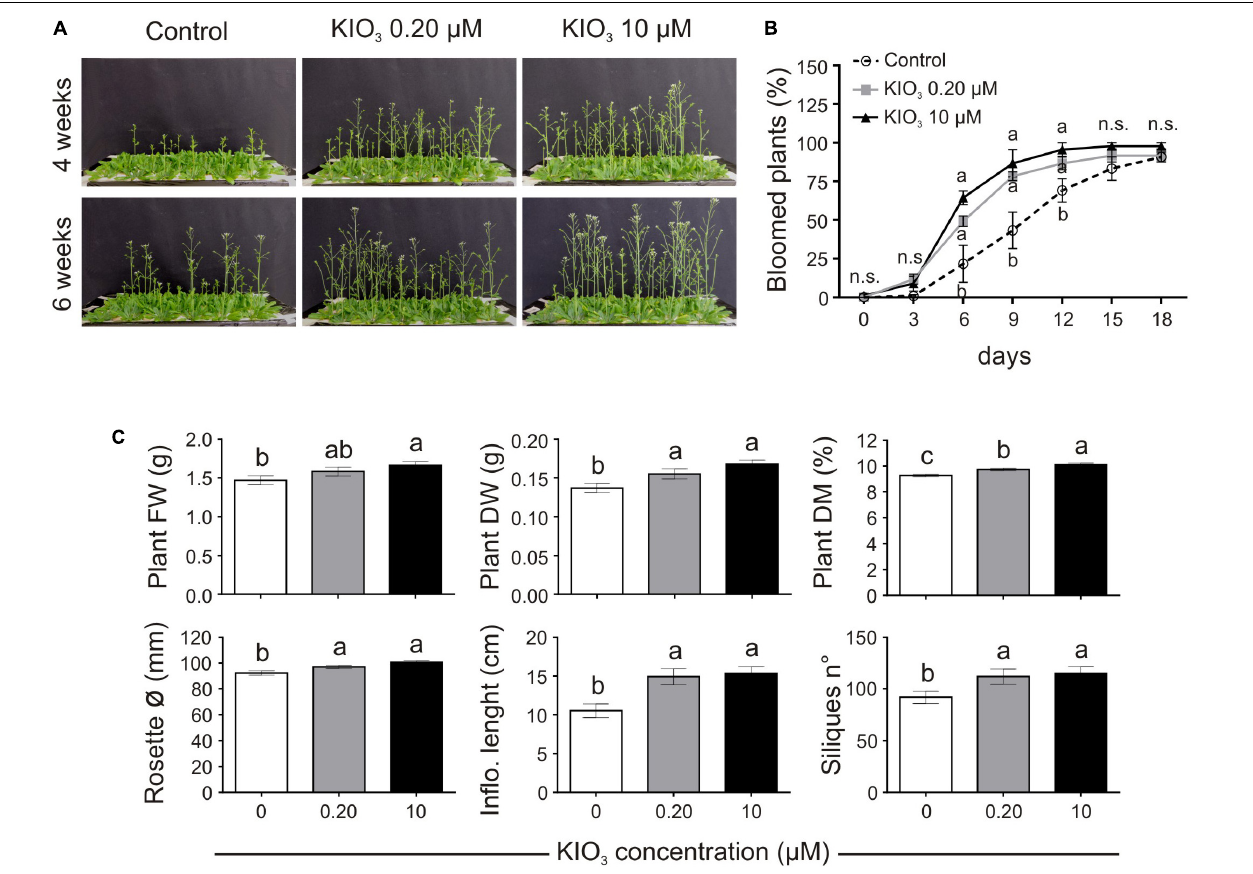
FIGURE 1 | Impact of iodine on plant growth and development (exp. 1-phenotype). (A) Lateral view of plants after 4 or 6 weeks from the onset of KIO 3 treatment. (B) Flowering time curve; the percentage of bloomed plants/tray was calculated every 3 days after the opening of the first flower (day 0). (C) Morphological data on plant FW, DW, dry matter content, rosette diameter, inflorescence length and number of produced siliques/plant, determined 1 month after the onset of KIO 3 treatments. Values indicated by different letters significantly differ from each other (according with one-way ANOVA, LSD post hoc test, P ≤ 0.05). In particular, the statistical analysis of flowering (B) was performed by comparing the percentage of bloomed plants of each tray (considered as biological replicates) within each sampling point. When data followed a Normal distribution and there was homogeneity of variances, they were subjected to one-way ANOVA and values indicated by different letters significantly differ from each other (LSD post hoc test, P ≤ 0.05). When one of this two prerequisite was violated, a Kruskal-Wallis test was performed. Error bars ( ± SE) are shown in